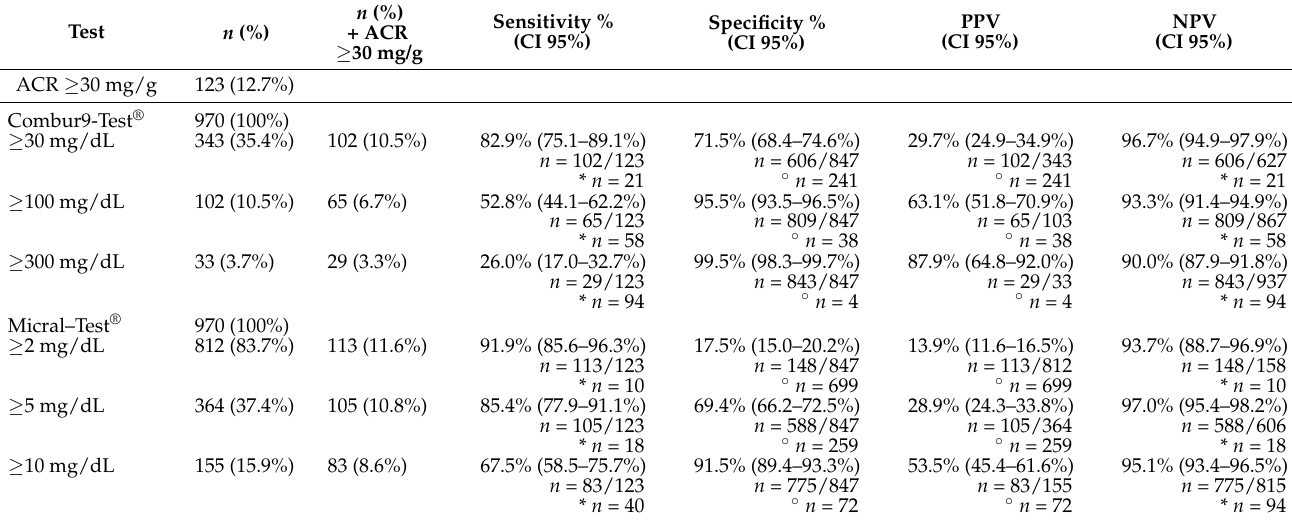
Table 2. Sensitivity, specificity, and negative and positive predictive values of semiquantitative colorimetric indicator- dye-based Combur9-Test ® and immunochromatographic Micral-Test ® compared with albumin-to-creatinine ratio (ACR) reference